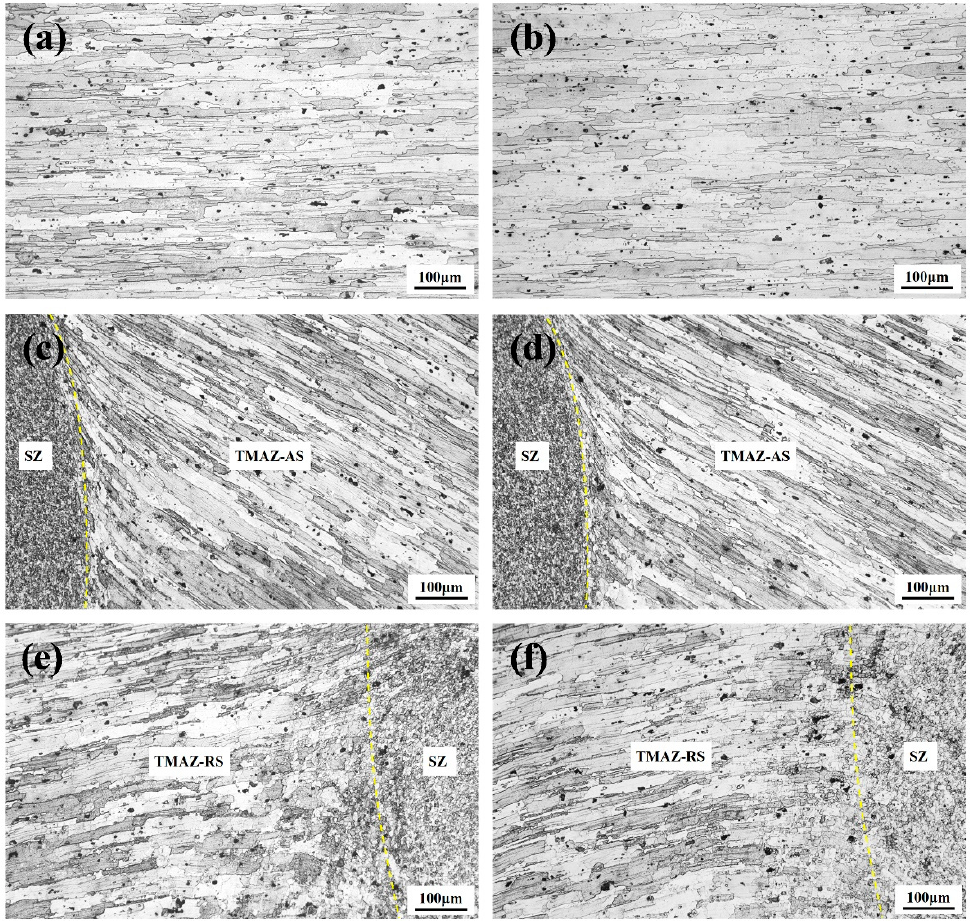
Figure 9. Microstructural images of the ( a ) base material, ( b ) heat-a ff ected zone, ( c ) TMAZ on AS of the FSLW joint, ( d ) TMAZ on AS of the UAFSLW joint, ( e ) TMAZ on RS of the FSLW joint, and ( f ) TMAZ on RS of the UAFSLW joint.